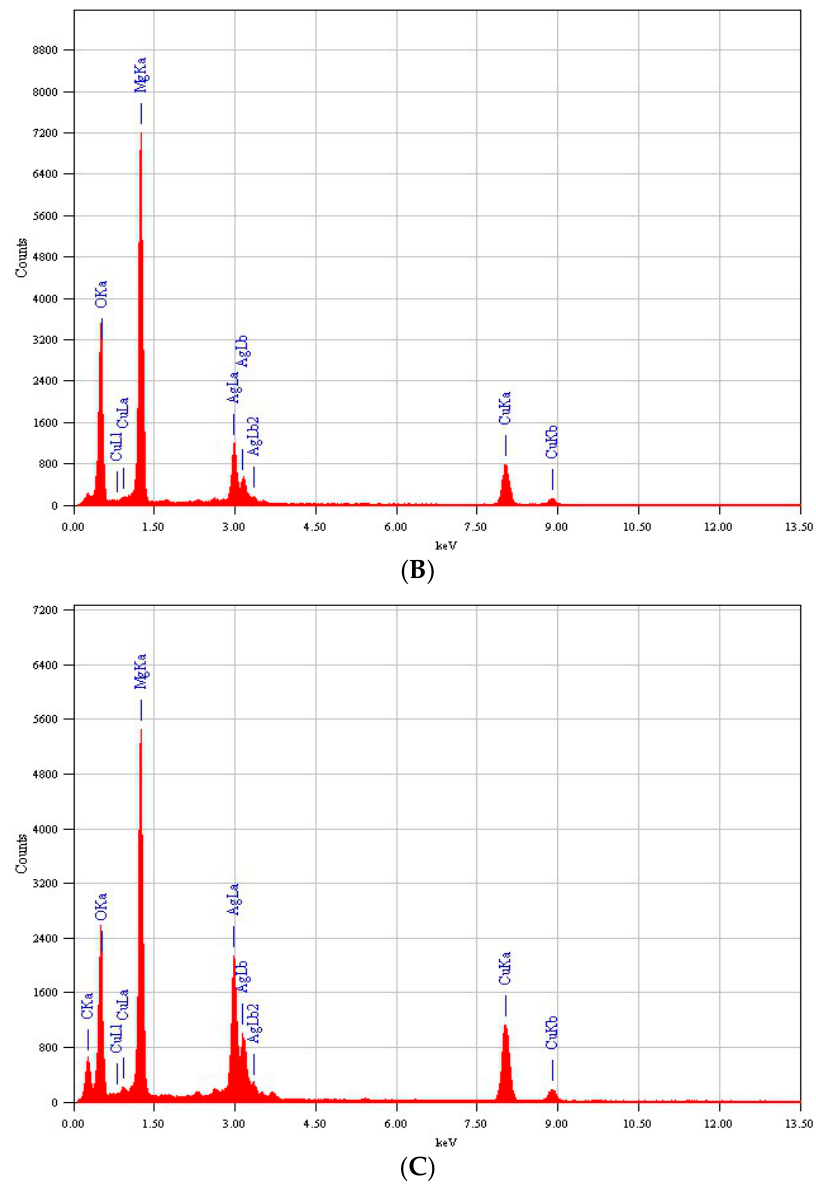
Figure 3. EDX spectra of pure ( A ), 5% Ag ‐ MgO NPs ( B ), and 7.5% Ag ‐ MgO NPs ( C ).